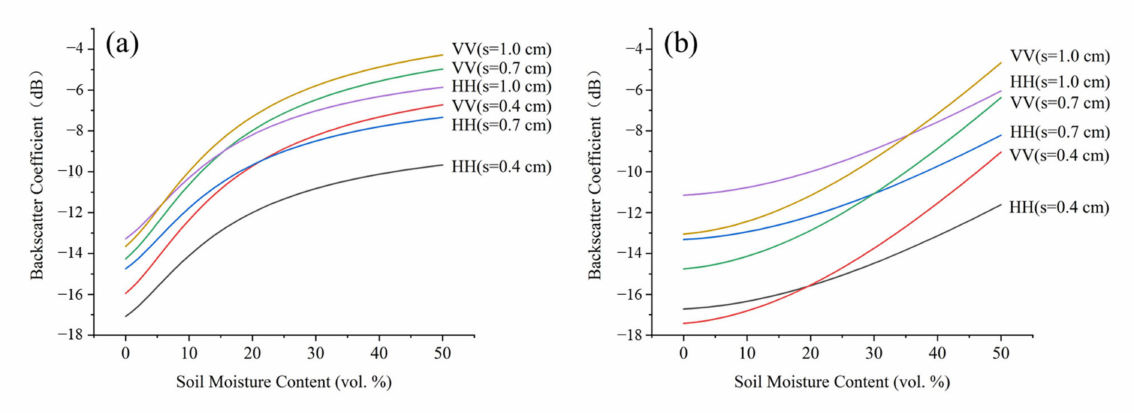
Figure 6. Simulated backscattering coefficients at different root mean square height and SMC conditions ( a ) CIEM; ( b ) Dubois Model.